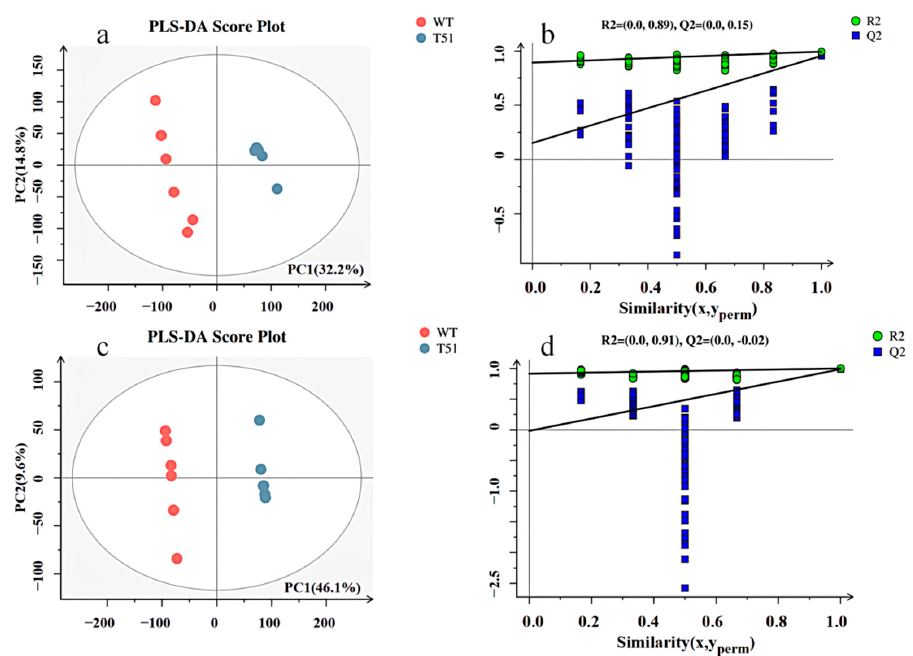
Figure 2. PLS-DA scores and permutation test plots scores between T51 and WT in positive and negative ion modes. Note: ( a ) PLS-DA scores in positive ion mode; ( c ) PLS-DA scores of negative ion mode; ( b ) permutation test plots scores of positive ion mode; ( d ) permutation test plots scores of negative ion